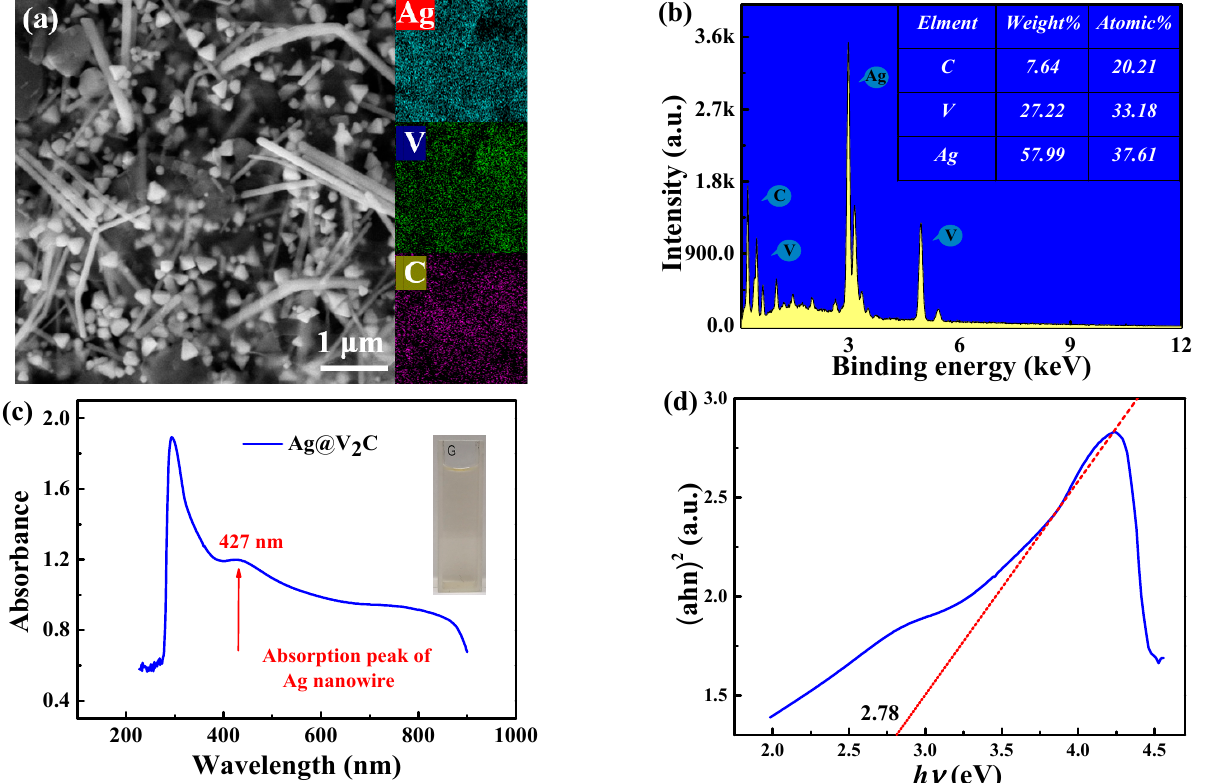
Figure 1. ( a ) SEM and EDS mappings of Ag V C elements. ( b ) EDS of Ag@V2C. The inset is atomic ratios for diverse elements. ( c ) Optical absorption spectra of Ag@V 2 C. ( d ) Estimation of the band gap of Ag@V 2